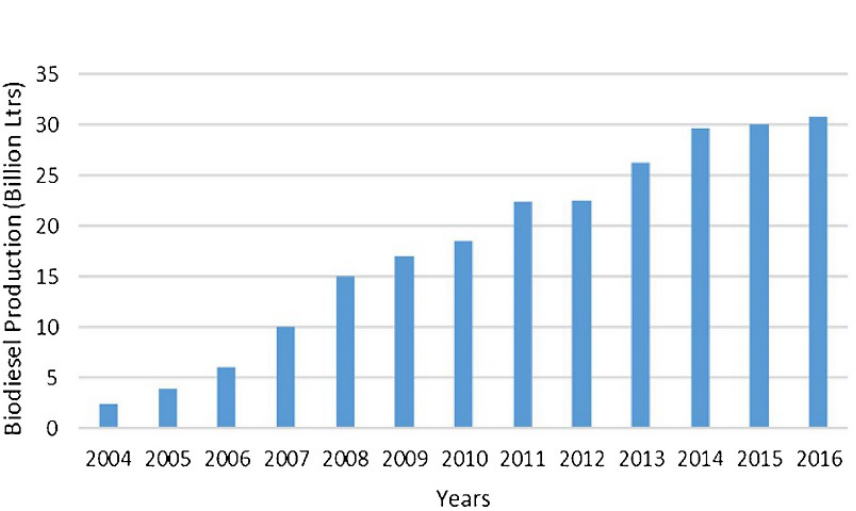
Figure 1. Worldwide production of biodiesel